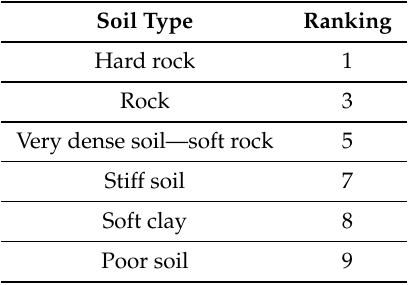
Table 8. ‘Soil type’ rankings considered in MCDM methods.